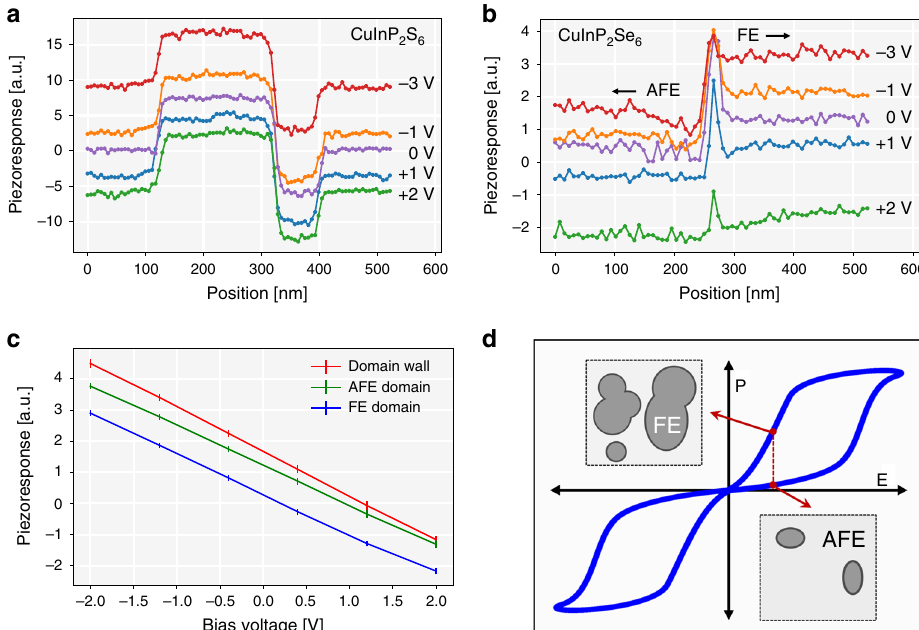
Fig. 3 Comparison of bias-dependent piezoresponse between CuInP 2 S 6 and CuInP 2 Se 6 . Piezoresponse line scans presented in Fig. 2(a – j) for a CuInP 2 S 6 and b CuInP 2 Se 6 at DC biases ranging from − 3V to + 2 V. c CuInP 2 Se 6 piezoresponse as a function of applied voltage for domain wall, AFE domain, and FE domain derived from Supplementary Fig. 2(d) Schematic of a canonical double-hysteresis loop for antiferroelectrics. Insets illustrate a schematic top view of the surface, with spatially separated AFE (light gray) and FE (dark gray)